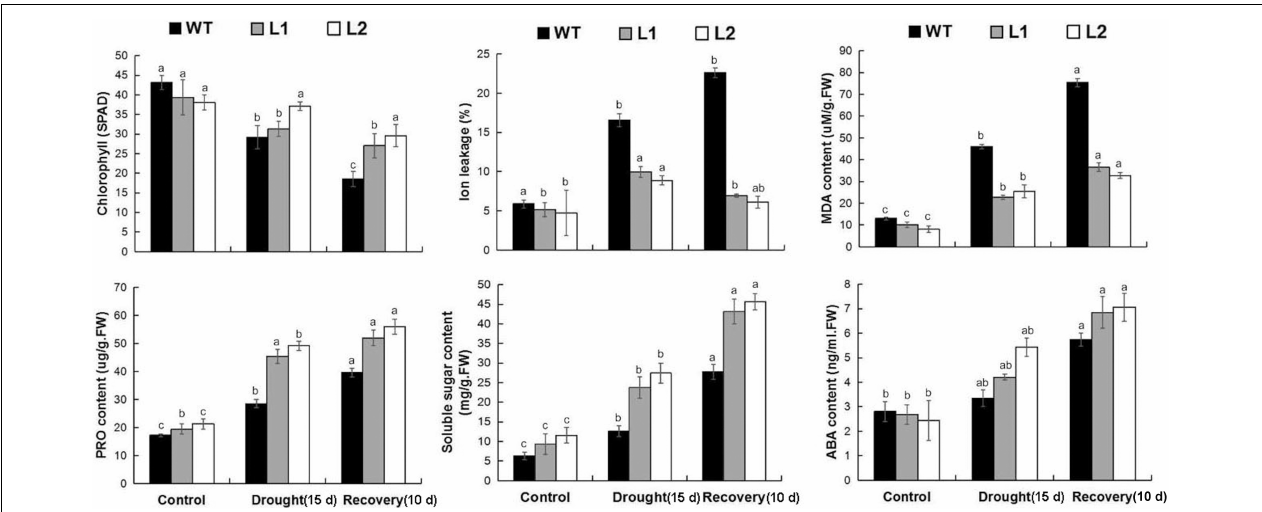
FIGURE 4 | Comparisons of physiological indices between WT and transgenic plants under normal, drought, and recovery conditions. Control means banana seedlings (100-day-old) grow normally. Drought means banana seedlings (100-day-old) were subjected to water withholding for 15 days, and recovery means banana seedlings (100-day-old) growth recovery for 10 days following 15 days drought treatment. Banana seedlings (100-day-old) were subjected to water withholding for 15 days and recovery for 10 days following 15 days drought treatment. The leaves were then sampled to perform physiological analyses. Data are means ± SD of n = 3 biological replicates. Means denoted by the same letter are not significantly different at P < 0.05 as determined by Duncan’s multiple-range test.